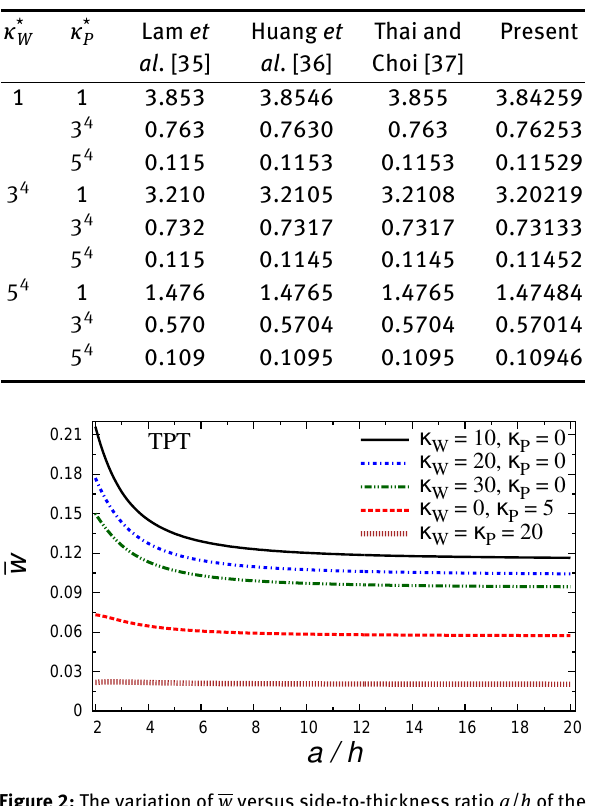
Figure 2: The variation of w versus side-to-thickness ratio a / h of the EG square plate resting on elastic foundations ( z = 0, k = 1.5) .